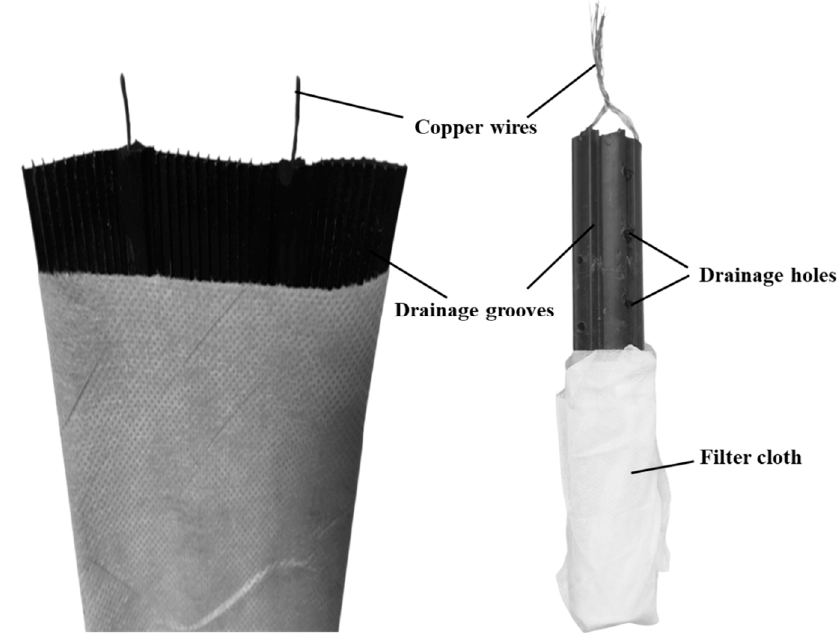
Figure 1. Tubular and flat EKG.